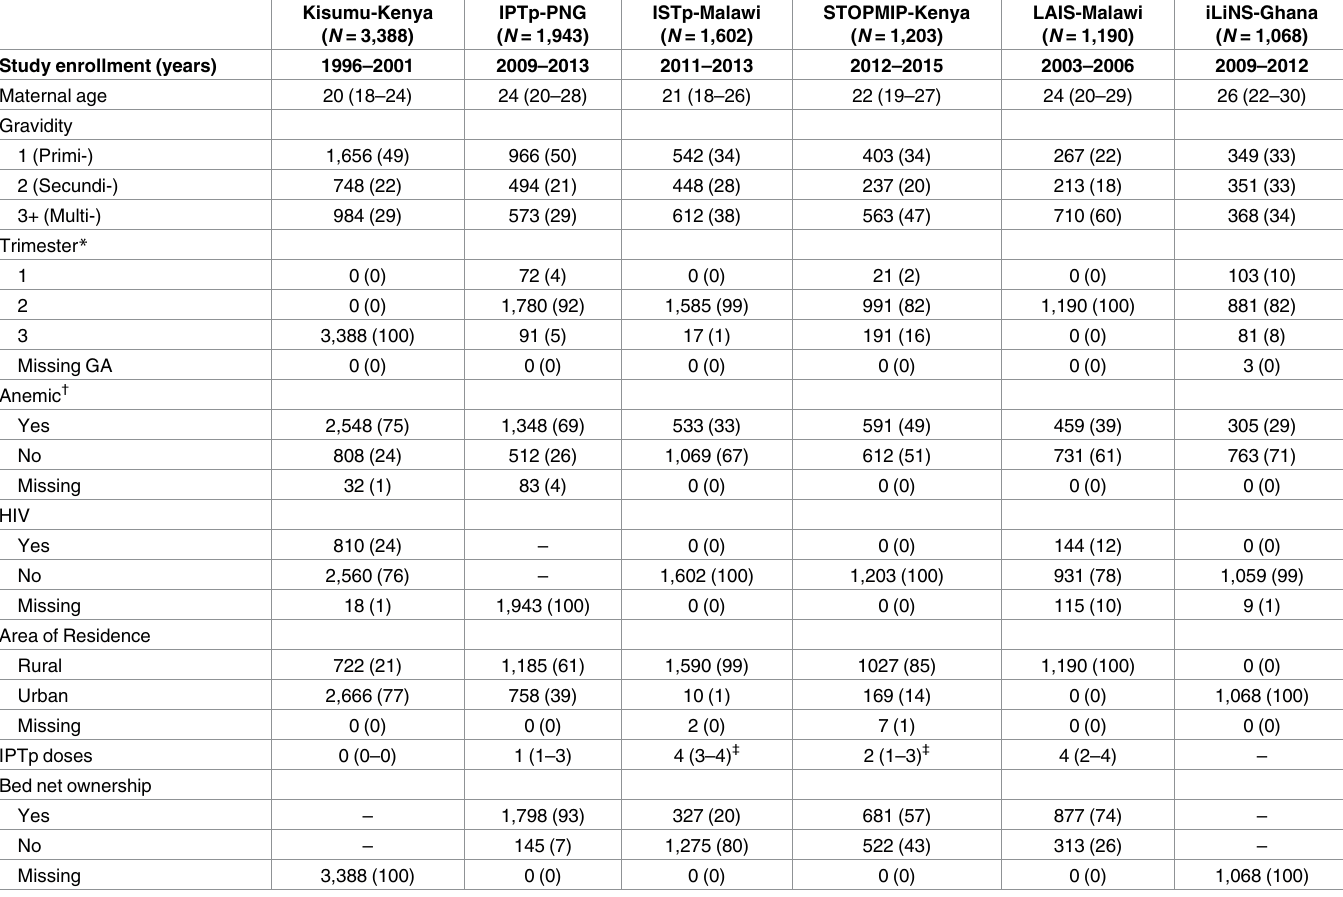
Table 1. The characteristics of women included in the Maternal Malaria and Malnutrition (M3) initiative from the following 6 out of 13 M3 studies: Kisumu-Kenya, IPTp-PNG, ISTp-Malawi, STOPMIP-Kenya, LAIS-Malawi, and iLiNS-Ghana.